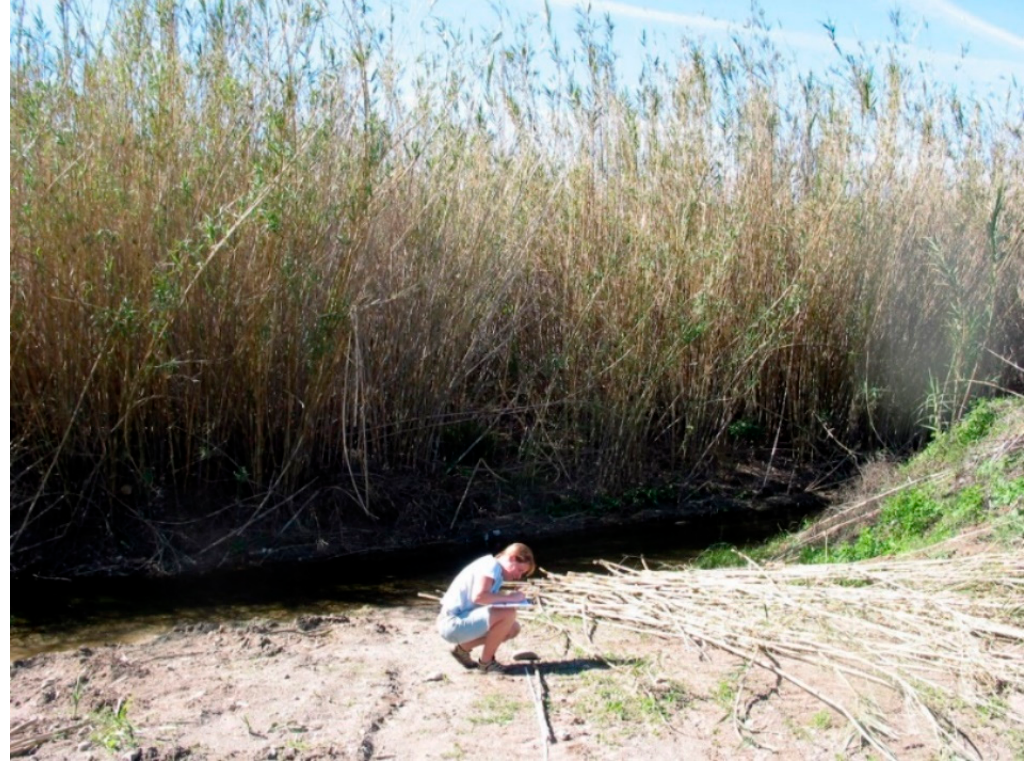
Figure 2. Photograph of A. donax in the floodplain of the Santa Clara River at study site S1. Height of plants in this picture exceeds 5 m tall.